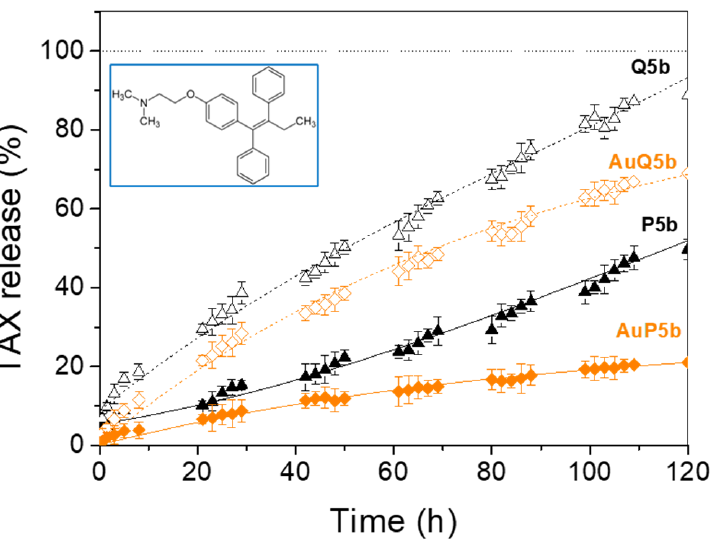
Figure 8. Cumulative amount of TAX (inset) released per time (hours) from pentablock terpolymer bare and hybrid micelles in PBS at pH 7.4. Each point is the mean from three independent measurements and bars represent standard deviation of means. The dotted lines are meant to provide guidance to the reader.